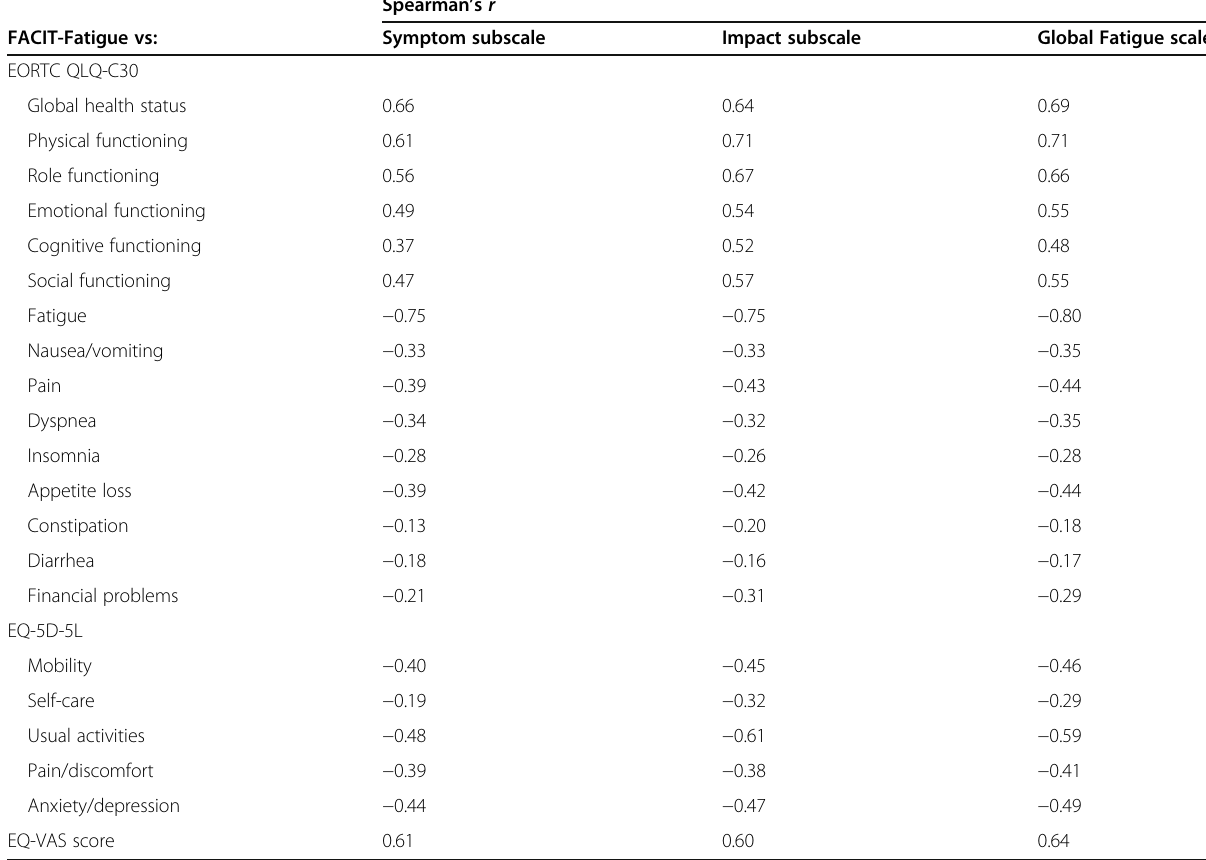
Table 4 Correlations to assess the convergent and divergent validity of the FACIT-Fatigue scales versus other measures